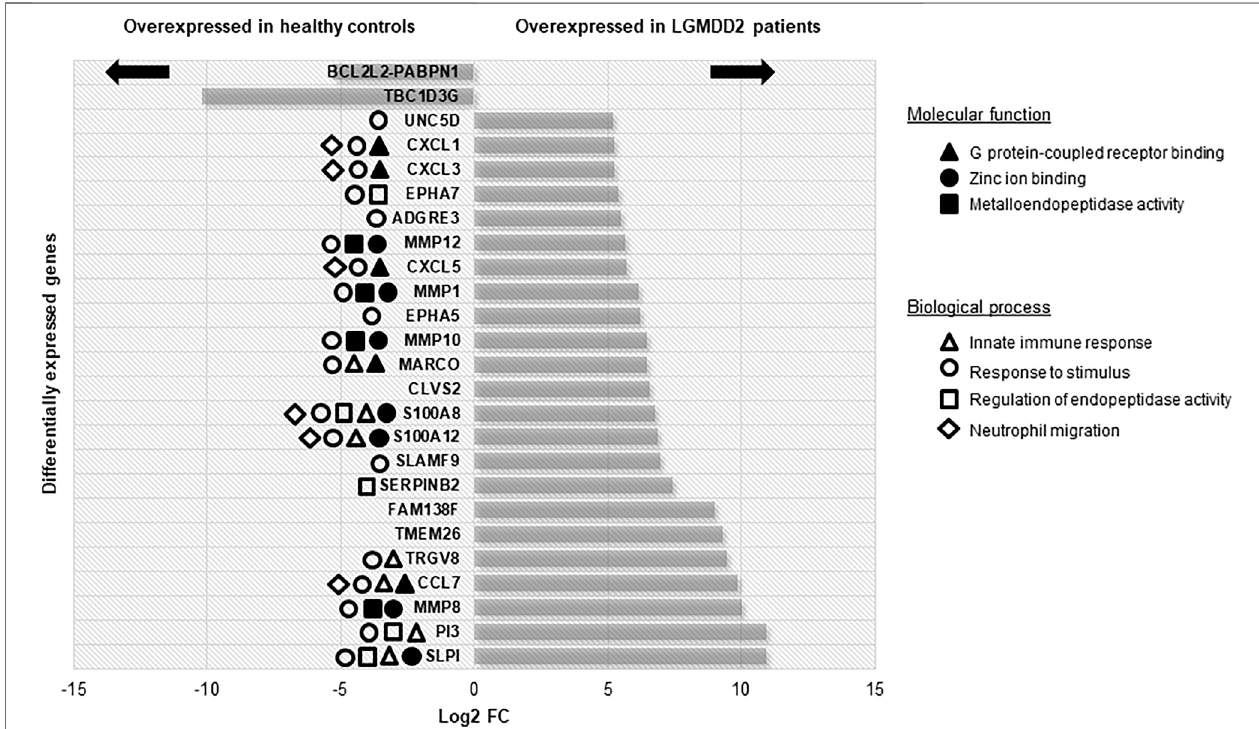
FIGURE 1 | Differentially expressed genes with higher FC between LGMDD2 patients and healthy controls. Functional annotation of these genes is shown according to the legend.